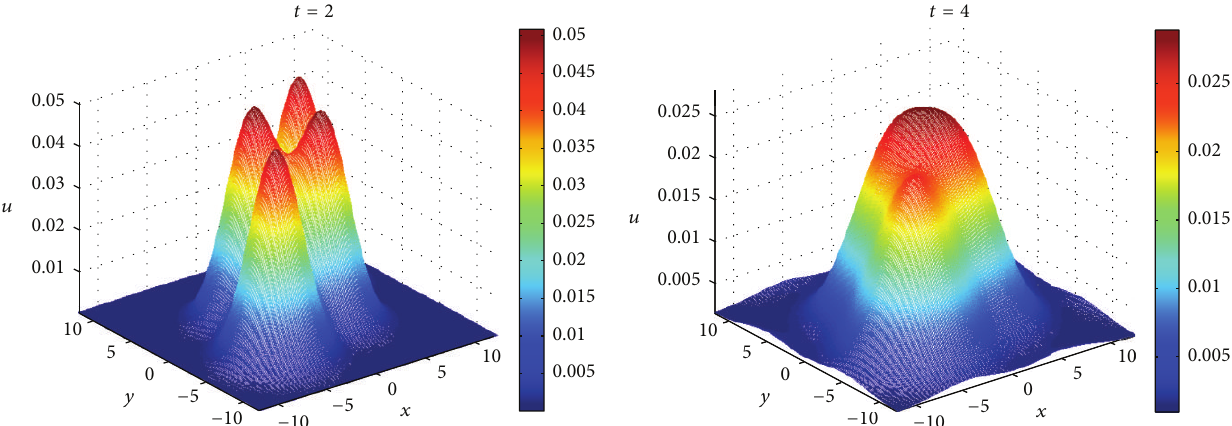
Figure 4: Persistence and existence of two-dimensional KiSS model (34) with initial population (36) at different time 𝑡 levels. Parameters are 𝛿 = 0.5 , 𝑝 = 2 , 𝜏 = 3 , and 𝐿 = 12 .